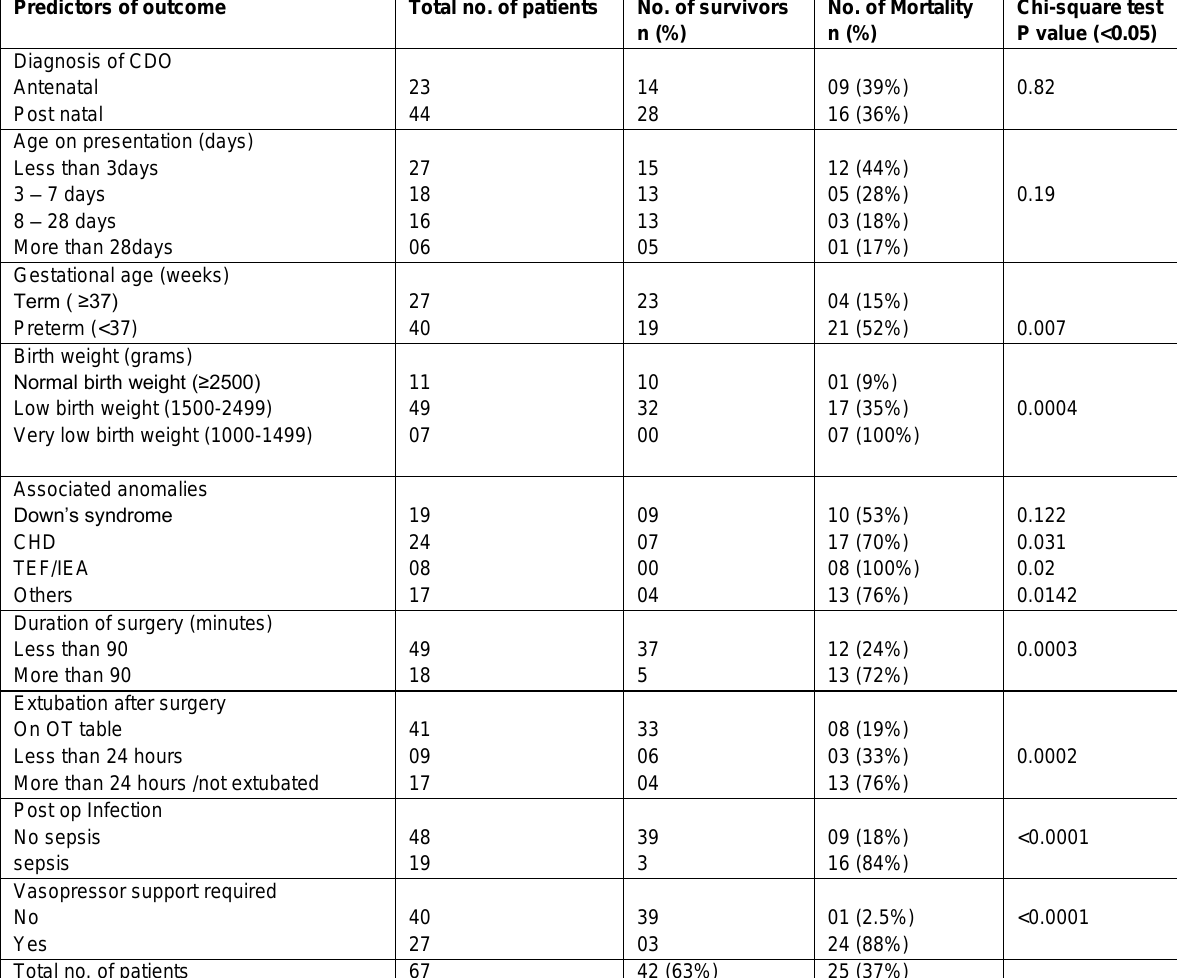
Table 4. Analytical data of predictor of mortality of patients with congenital intrinsic duodenal obstruction. Predictors of outcome Total no. of patients No. of